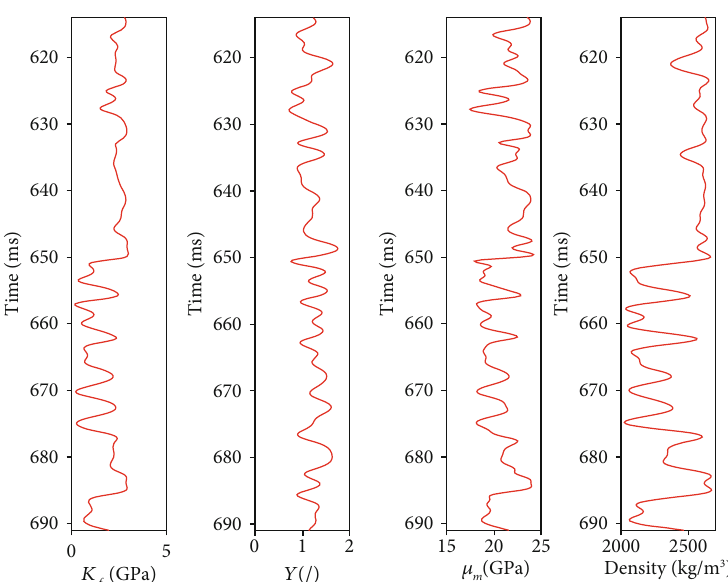
Y , μ f , m , and density of the real well log data used to test the inversion accuracy of the proposed formula